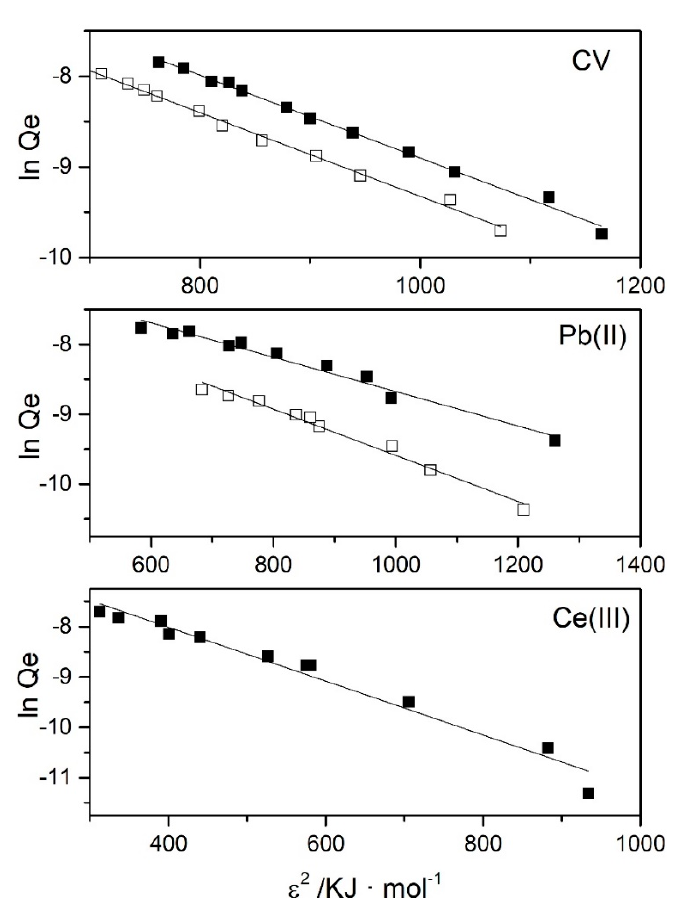
Figure 5. Dubinin–Radushkevich (DR) adsorption isotherms of CV, Pb(II) and Ce(III) onto K10-Mt performed at pH = 6.0 ( ■ ) and pH = 2.0 ( □ ). Lines correspond to the fi t by DR model.